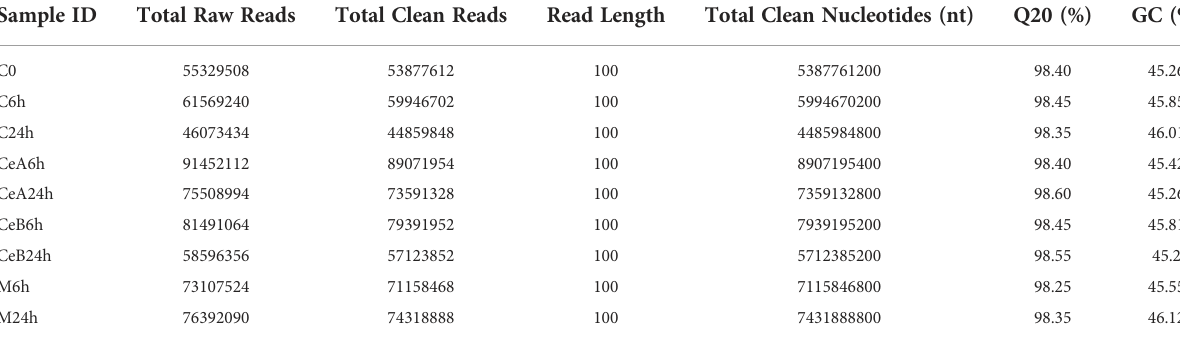
TABLE 1 Statistics of Transcriptome Sequencing Data of T. mairei . Sample ID